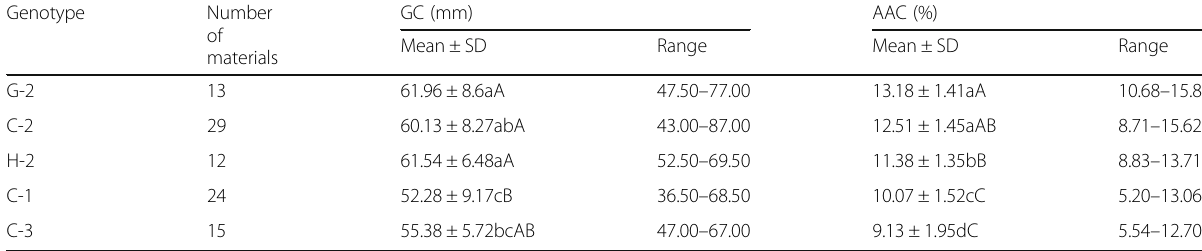
Table 3 Comparison of GC and AAC among different combinations of PUL and SSIV-2 alleles